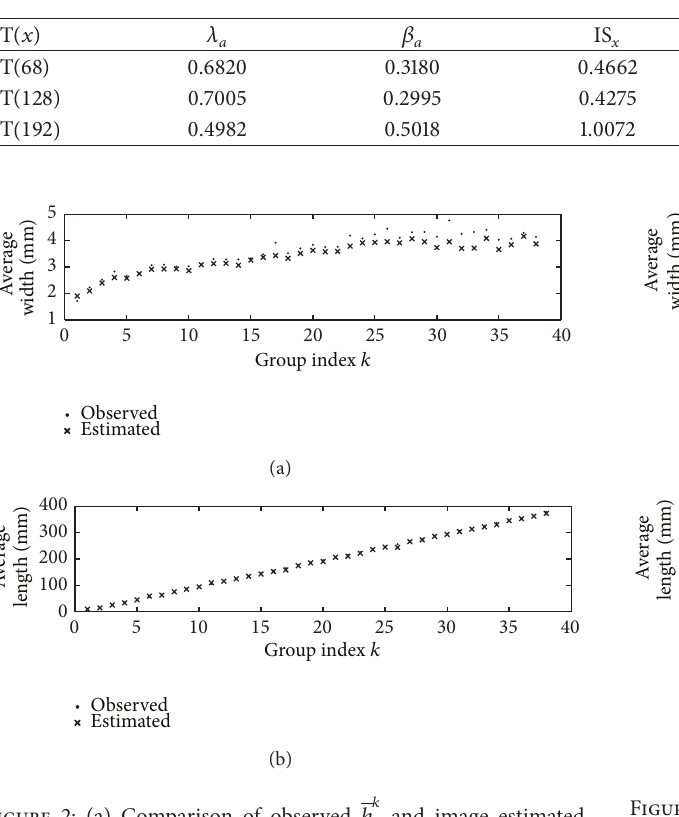
Table 8: Proportions of overestimation and underestimation of leaf area and selection index values for a given ST (𝑥) range.